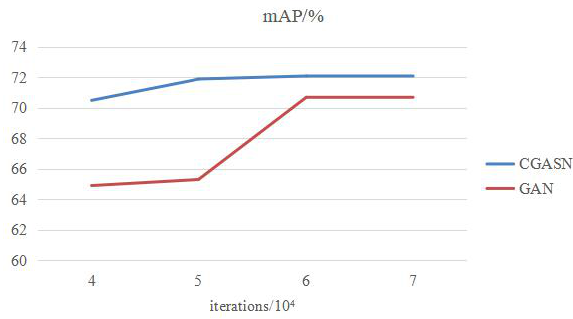
Fig. 5. Training convergence with different models.